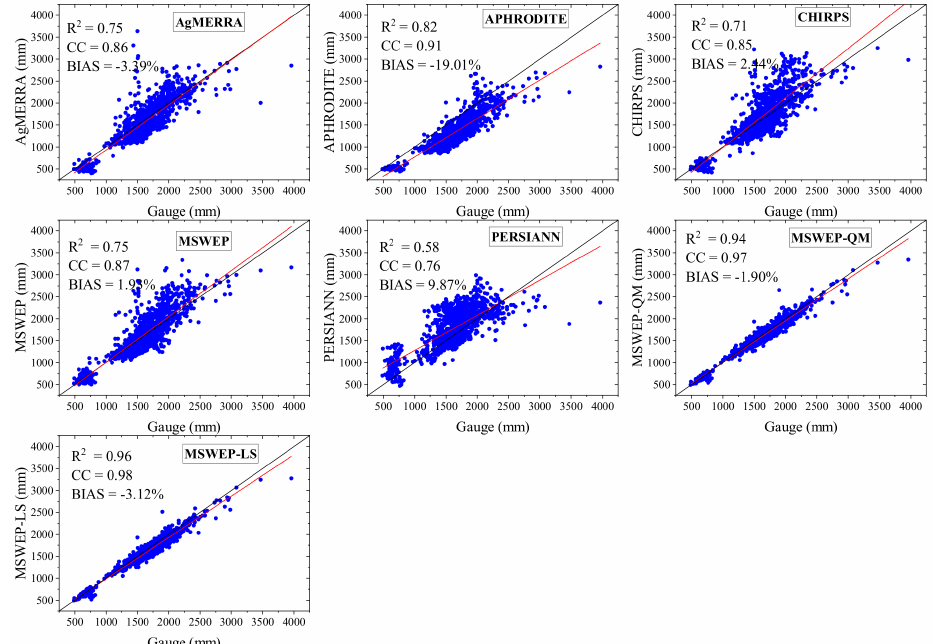
Figure 9. Scatterplot of annual average precipitation of gauge observations against AgMERRA, APHRODITE, CHIRPS, MSWEP, PERSIANN, MSWEP-QM, and MSWEP-LS from 1998 to 2007. The diagonal line is black, and the best linear fit line is red which using the least squares